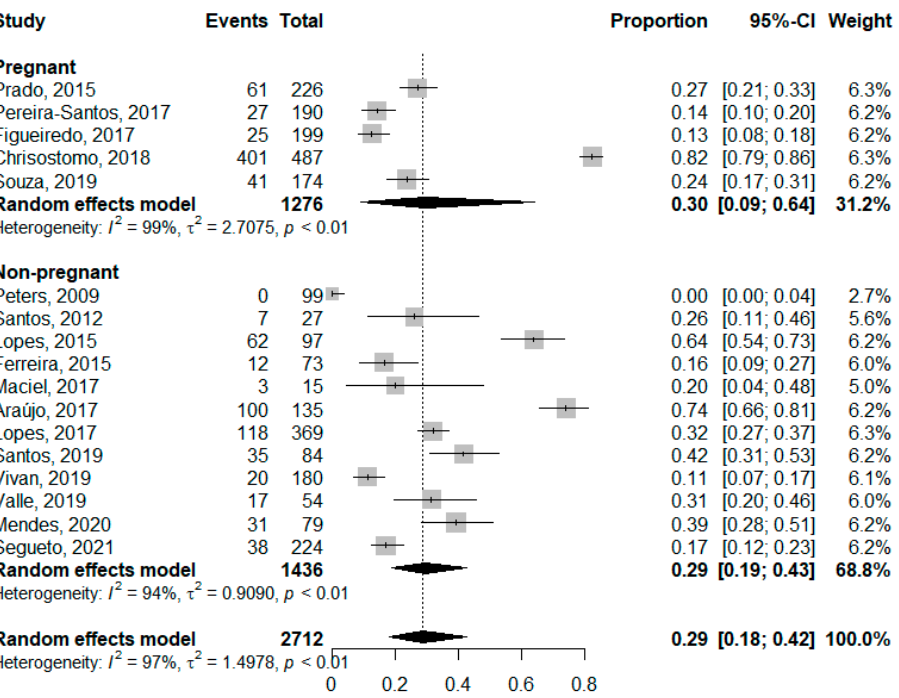
Figure 2. Prevalence of Vitamin D deficiency in childbearing women stratified by pregnancy status. [33–37,39–49]. The vitamin D insufficiency (Figure 4) was of 59% (95% CI: 0.51–0.67; I 2 : 93%), with no differences between pregnant and non-pregnant women. A higher prevalence of vitamin D insufficiency was observed in the South region than in the other regions, although the confidence intervals did not show significant differences (Figure